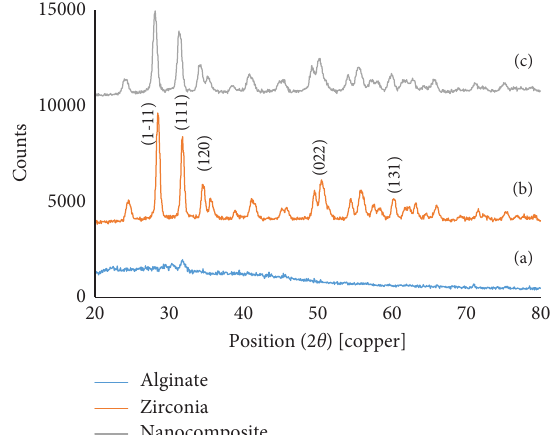
Figure 2: X-ray difraction (XRD) patterns of alginate biopolymers (a), zirconia NPs (b), and alginate/zirconia nanocomposites (c).